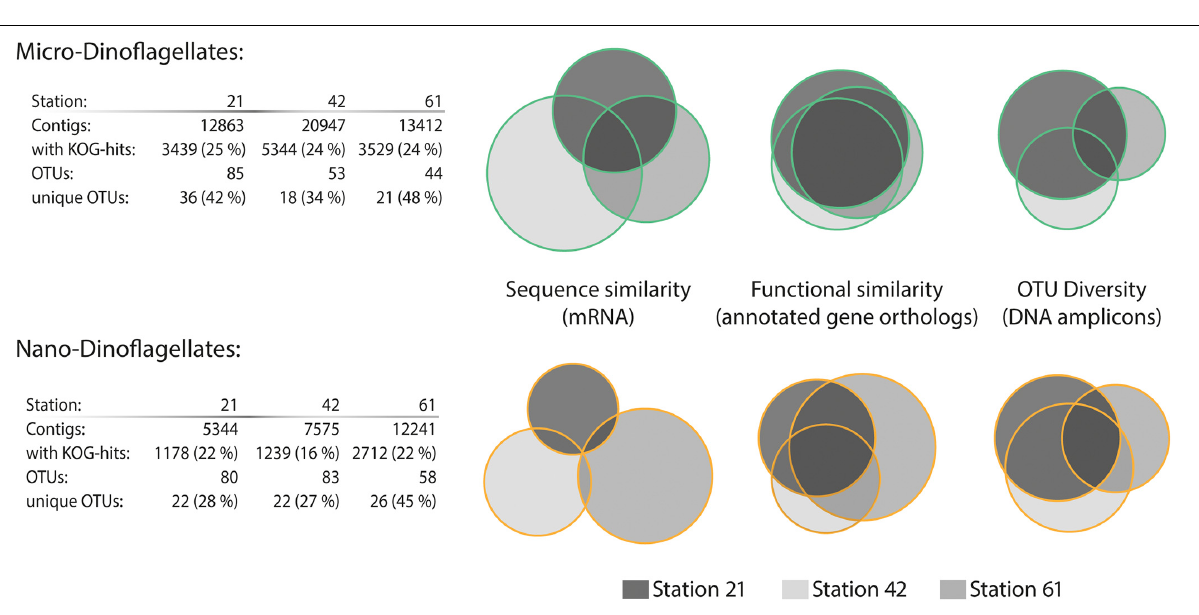
FIGURE 2 | Sequence diversity and functional similarity of the dinoflagellate metabarcode and metatranscriptome assemblages. Sequence similarity of the SL-mRNA is based on an identity cut-off of 95%; sequence diversity of the operational taxonomic units (OTUs, 28s-rDNA) is based on an identity cut-off of 98%. Functional similarity is based on KOG (eukaryotic orthologous groups) annotation terms. Information about the total numbers of assembled contigs and the fraction with assigned KOG annotations ( e -value ≤ 10 − 5 cut-off) is given in the table below for each station and size